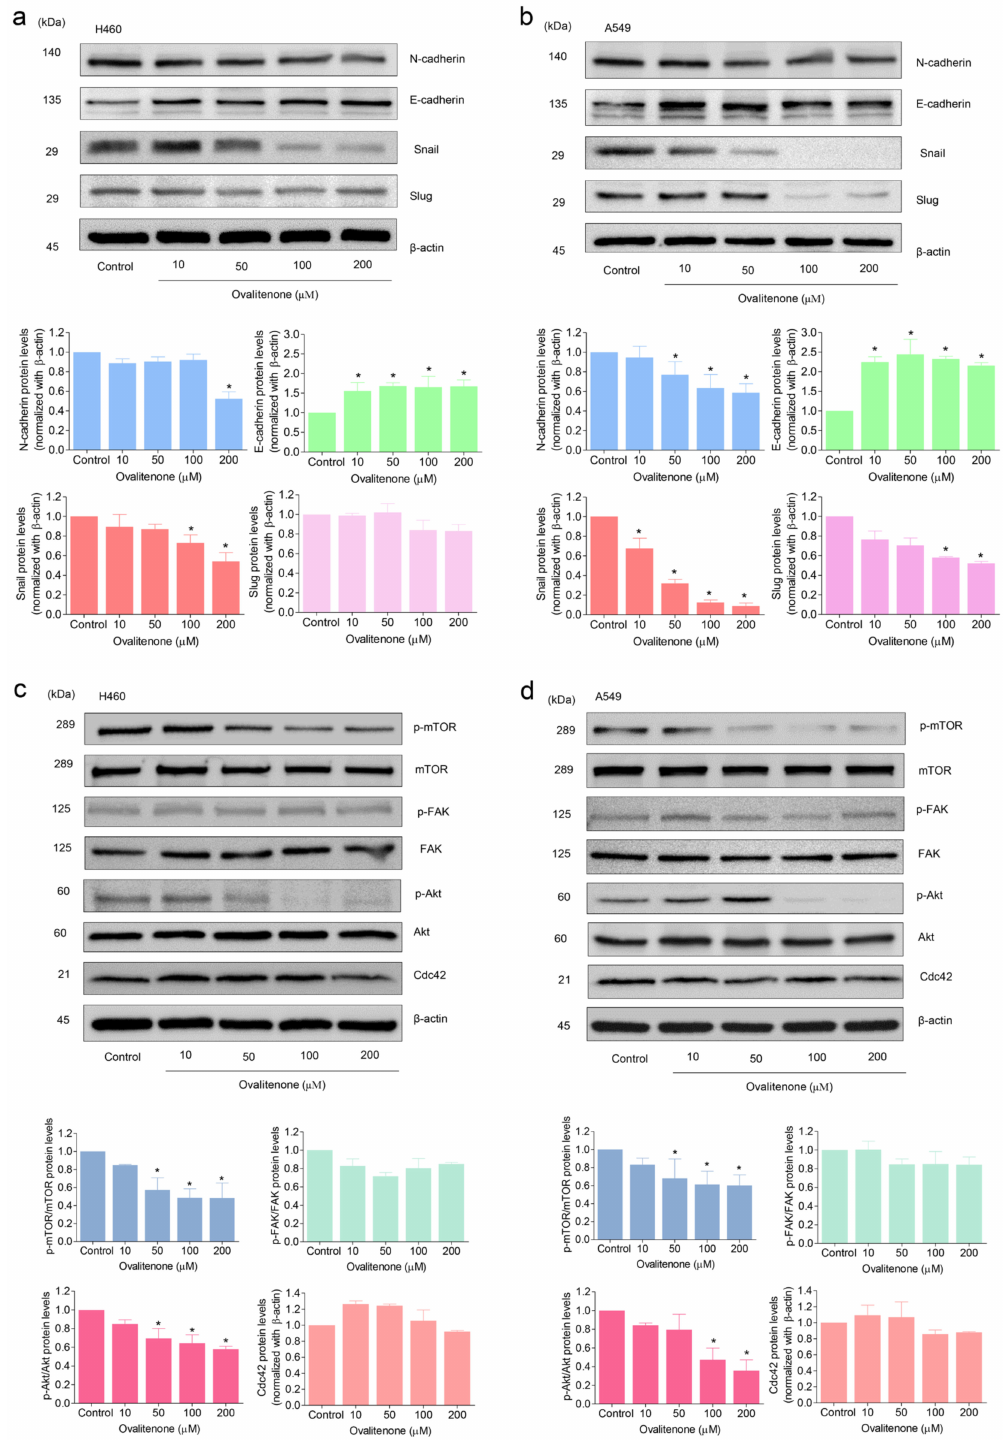
Figure 4. Ovalitenone suppresses epithelial-to-mesenchymal transition (EMT) through inhibition of the ATP-dependent tyrosine kinase (AKT)/mammalian target of rapamycin (mTOR) signaling pathway. ( a , b ) After cells treated with non- toxic concentrations of ovalitenone for 24 h, the expression levels of N-cadherin, Snail and Slug were determined by Western blotting. ( c , d ) Levels of phosphorylated mTOR (Ser2448), phosphorylated focal adhesion kinase (FAK) (Tyr397), phosphorylated Akt (Ser473), and Cdc42 were determined by Western blot analysis. All data are represented by mean ± SEM ( n = 3). * p < 0.05 compared with untreated